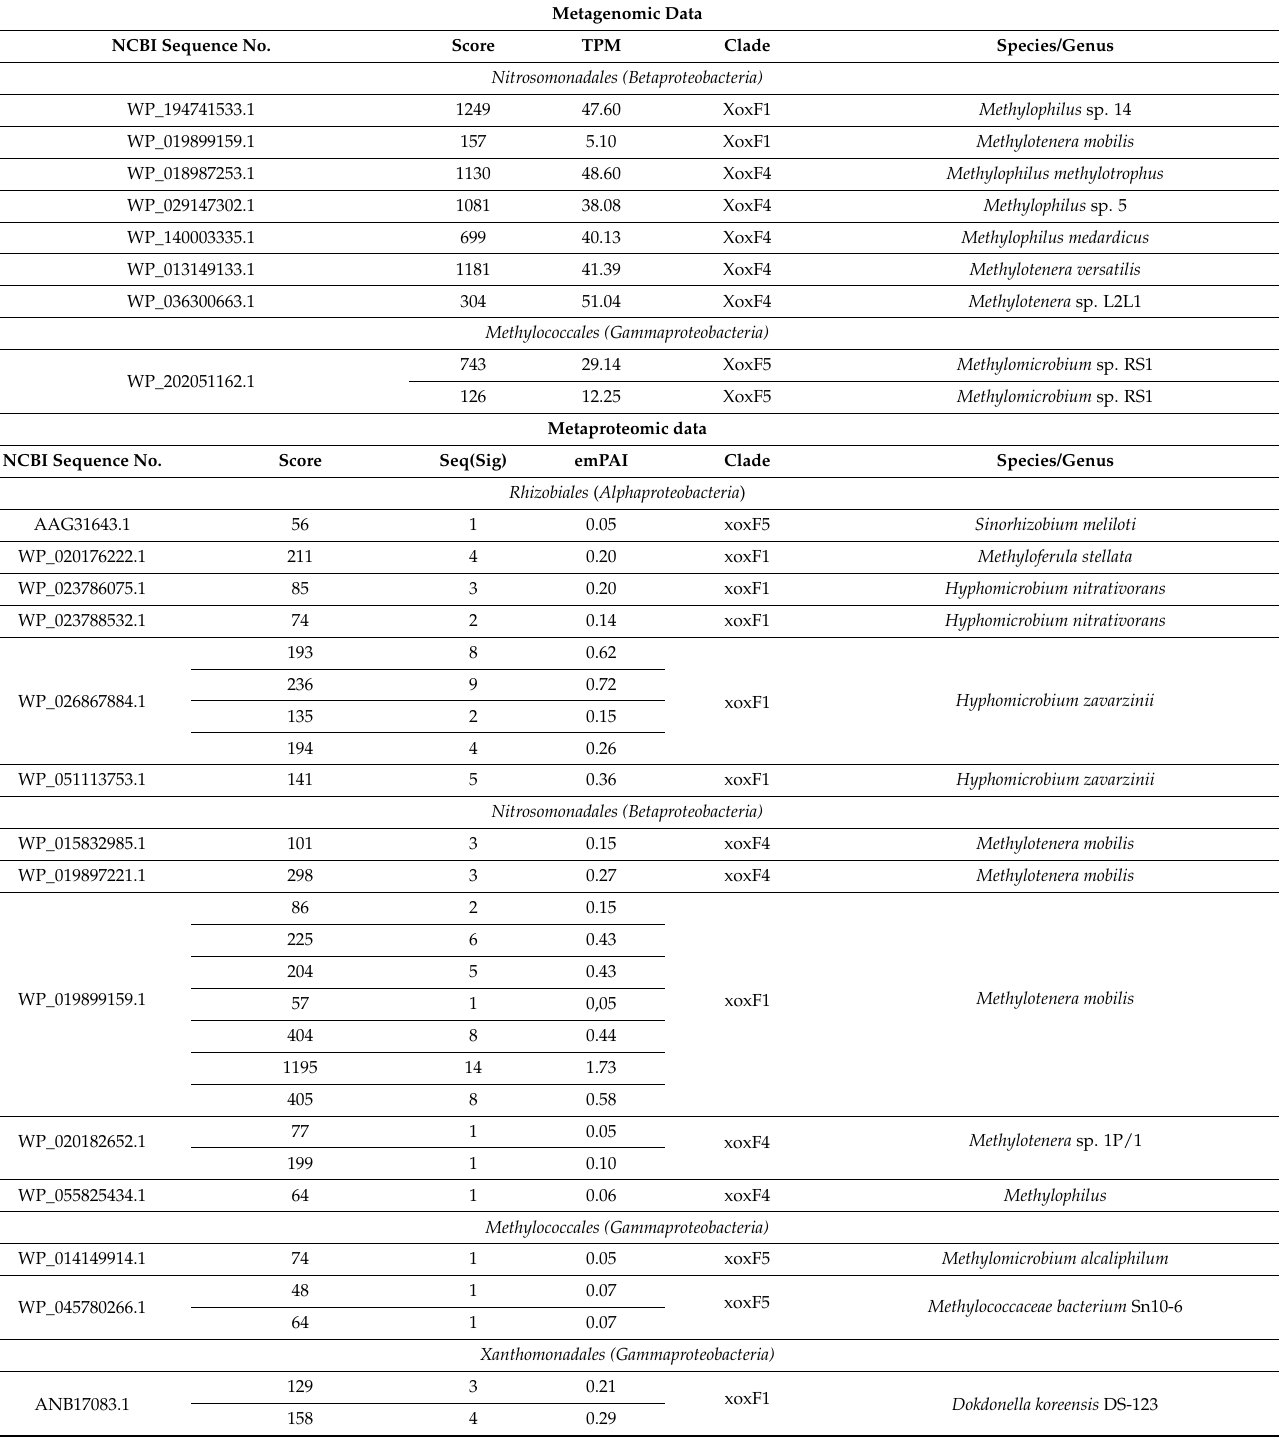
Table 1. XoxF-EG and XoxF enzymes (EC 1.1.2.10) detected in the studied microbial community. Metagenomic